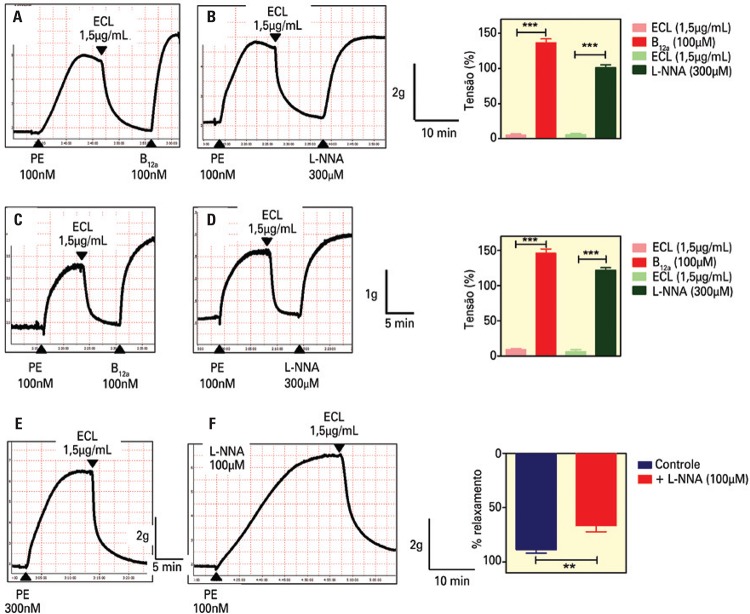
Traçados representativos mostrando a reversão de relaxamento induzido por extrato de Combretum leprosum (ECL) por hidroxocobalamina (B12a; 100µM) ou L-NG-nitro-L-arginina (L-NNA; 300µM) nos anéis da aorta torácica de coelho (A, B) ou de rato (C, D). Em (E e F), traçados representativos mostrando o relaxamento induzido por ECL na ausência (E; n=8) e na presença de L-NNA (F; 100µM, n=7) em anéis da aorta abdominal de coelho. Os painéis do lado direito (A-D) mostram os valores médios ± erro padrão da média (EPM) da tensão de 4-8 experimentos semelhantes (tensão expressa como uma porcentagem da contração induzida por fenilefrina - PE). **Teste bicaudal p=0,0041 (teste t não pareado); ***teste bicaudal p<0,0001 (teste t pareado). O painel do lado direito (E-F) mostra os valores médios ± EPM do relaxamento induzido por ECL (magnitude do relaxamento expresso como porcentagem da contração induzida por PE)